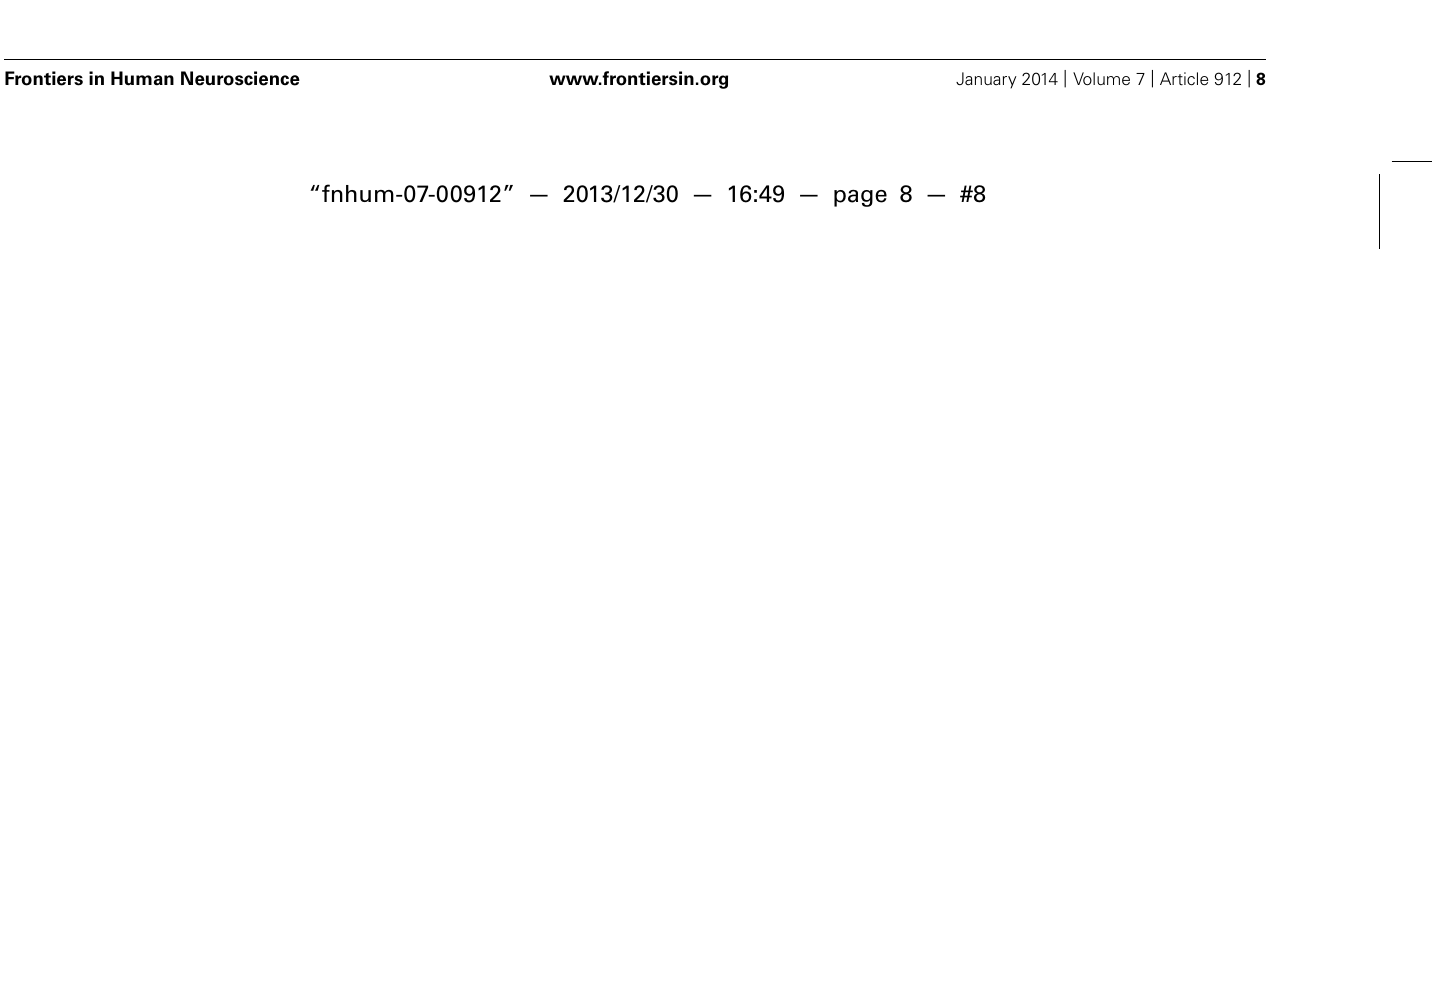
be associated with initiating an avoiding behavior. This new event processes new sensory information integrated with motor information and the relevant environment (e.g., standing on a stable or unstable support) that primes the following event. The idea is that this scheme is reproduced in all sensorimotor